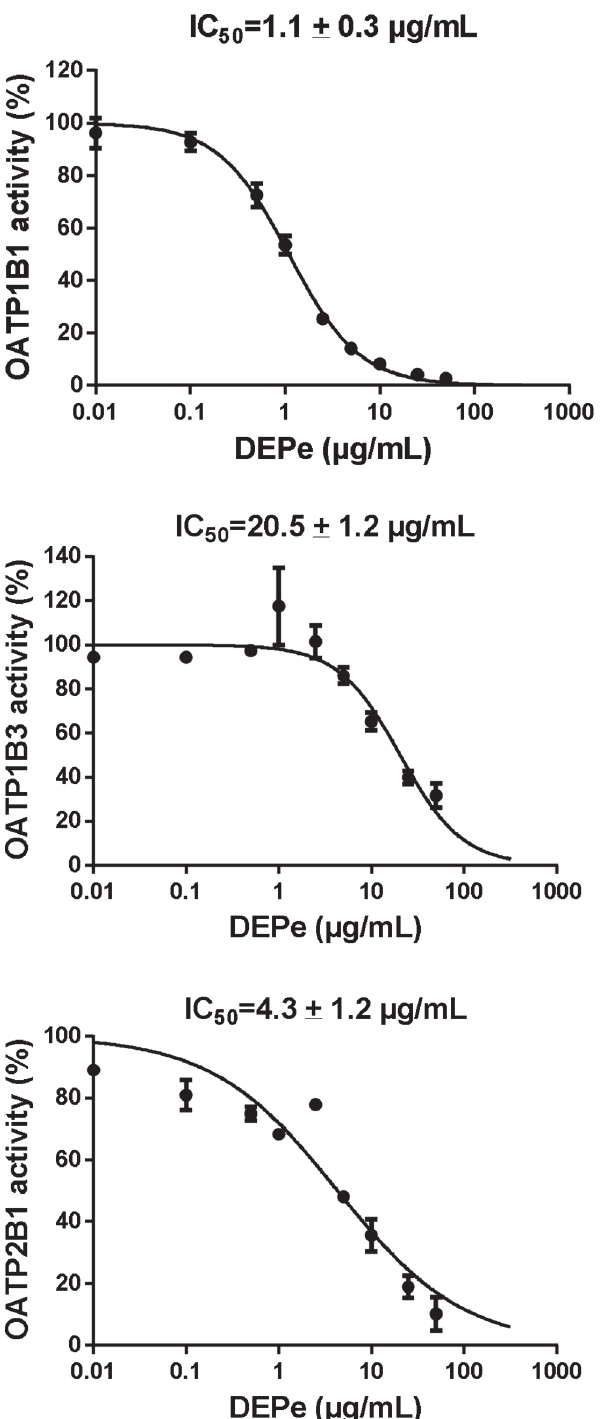
Fig 2. Concentration-dependent inhibition of OATP1B1, OATP1B3 and OATP2B1 activity by DEPe. OATP1B1- and OATP2B1-mediated transport of E3S and OATP1B3-mediated transport of fluorescein were determined in OATP-transfected CHO cells in the absence or presence of various concentrations of DEPs (from 0.1 to 50 μ g/mL) or of the reference inhibitors 100 μ M bromosulfophtalein (for OATP1B1 and OATP2B1) or 10 mM probenecid (for OATP1B3). Data are expressed as % of OATP activity calculated as described in Materials and Methods and are the means ± SEM of three independent assays. DEPe IC 50 values are indicated at the top of the